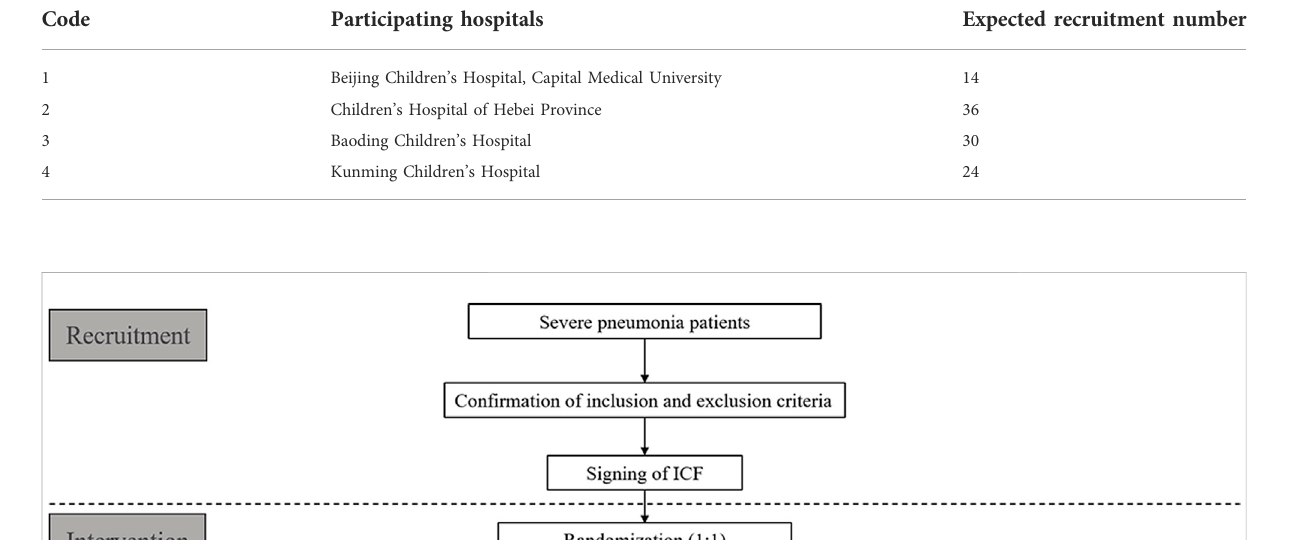
TABLE 1 Hospitals participating in this trial.